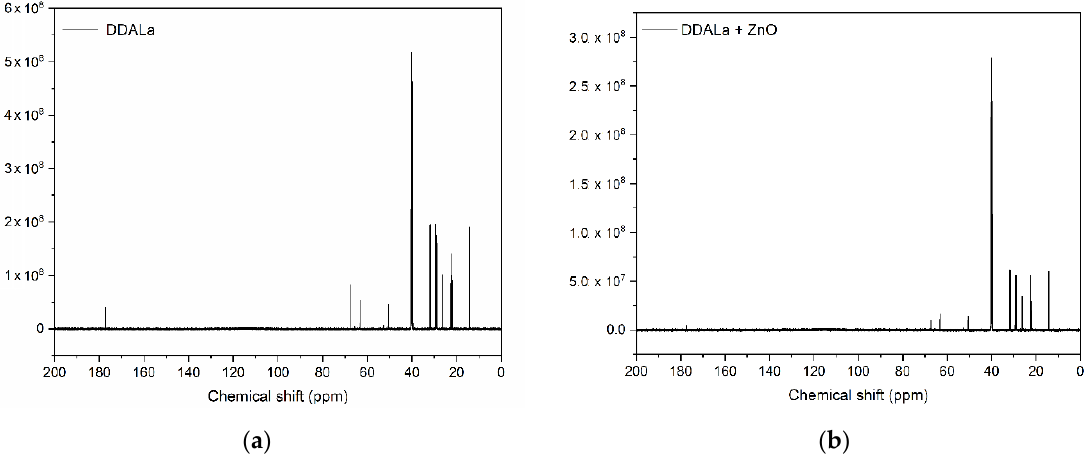
Figure 13. 13 C NMR spectra: ( a ) pure DDALa; ( b ) 1:2 mixture of DDALa and ZnO.